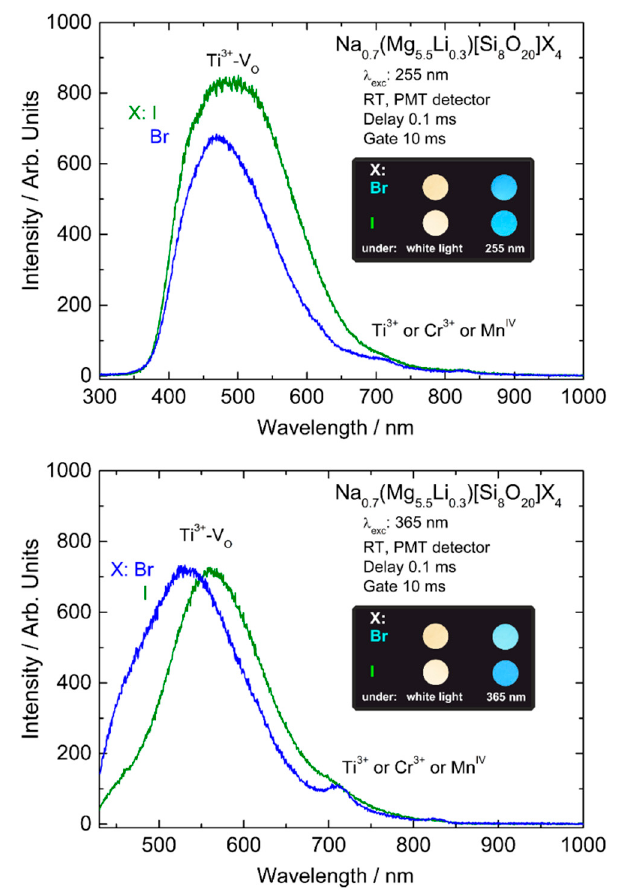
Figure 7. The emission spectra of the bromohectorite and iodohectorite under 255 nm ( top ) and 365 nm ( bottom ) excitation. The inserted photos illustrate the visual aspect of the materials under white light and when irradiated with 255 nm or 365 nm.